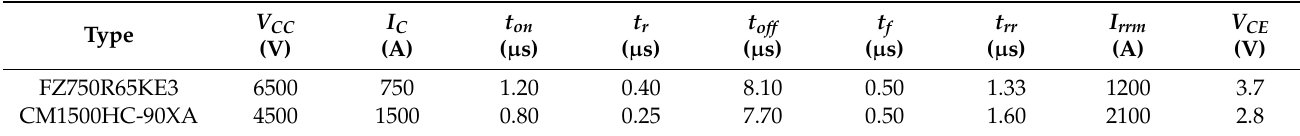
Table 2. Parameters of IGBTs.